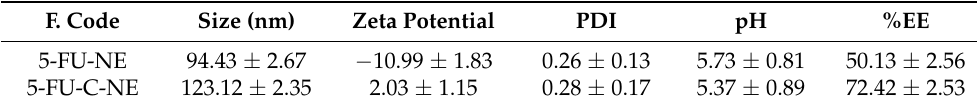
Table 2. Physicochemical properties of the formulated nanoemulsion at 40 ◦ C. F. Code